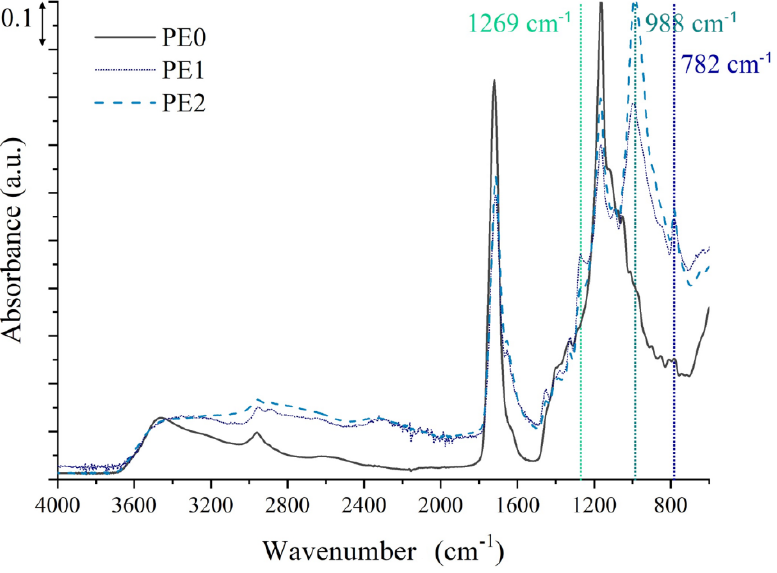
Figure 4. ATR-FTIR spectra of phosphate-containing bio-based polyesters PE1 and PE2 and polyester without phosphate as reference PE0.